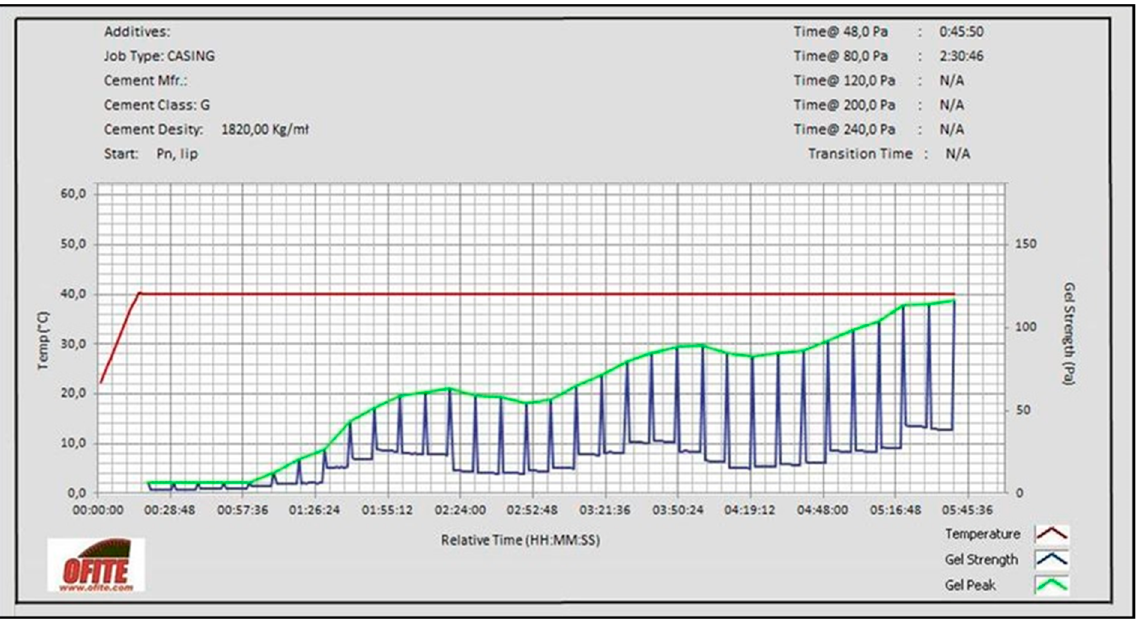
Figure 7. Course of the gas migration test during bonding for slurry with low anti-migration resistance.